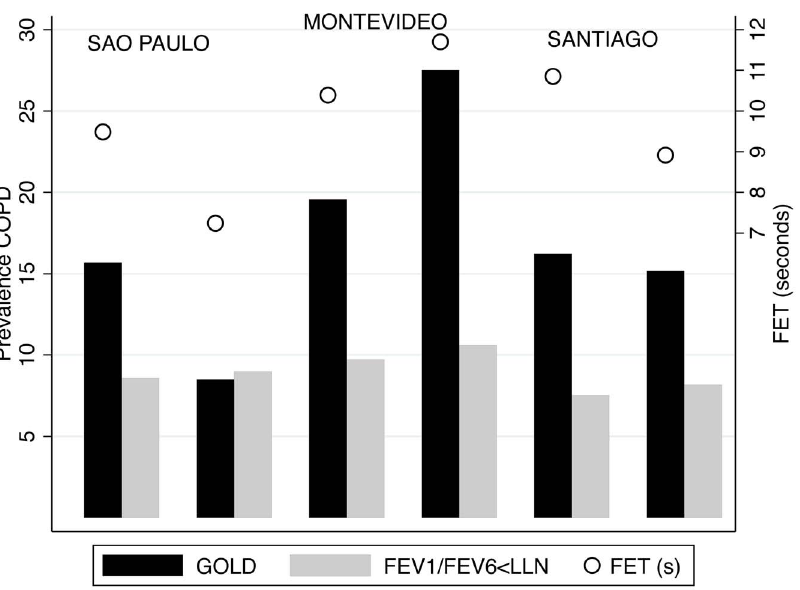
Figure 1. Prevalence of Chronic obstructive lung disease (COPD) by Global Initiative for Chronic Obstructive Lung Disease (GOLD) criteria (black bars) based on Forced expiratory volume in one second (FEV 1 )/Forced vital capacity (FVC) , 0.7, and by FEV 1 / FEV 6 , Lower limit of normal (LNN) ( , 5th percentile for FEV 1 /FEV 6 , gray bars) in the three cities during baseline and follow-up. In addition, mean Forced expiratory time (FET) is plotted (right scale, empty circles) for the post-Bronchodilator tests (post-BD). Prevalence of COPD by FEV 1 /FVC criteria (GOLD) varies directly with Forced expiratory time (FET), unlike prevalence based on FEV 1 /FEV 6 . Prevalences based on a FEV 1 / FVC , LLN also depend to a great extent on FET (not shown).